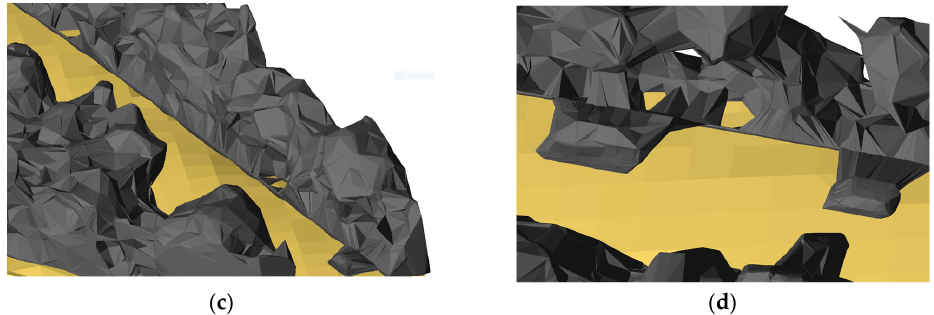
Figure 6. Visual comparison of distinct aboveground models. ( a ) Aerial view of the model with 20 cm as maximum edge length; ( b ) close-up of the previous view; ( c ) oblique aerial view of the model with up to 2 m edge length; ( d ) close-up of the previous image, here two cars are merged with vegetation and the crash barrier.